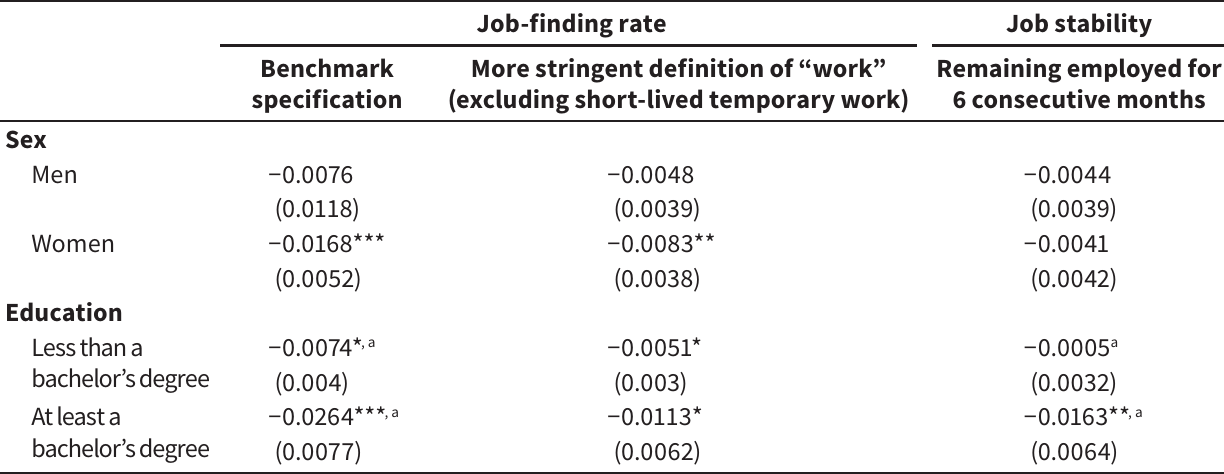
The effect of the subsidy by gender and level of